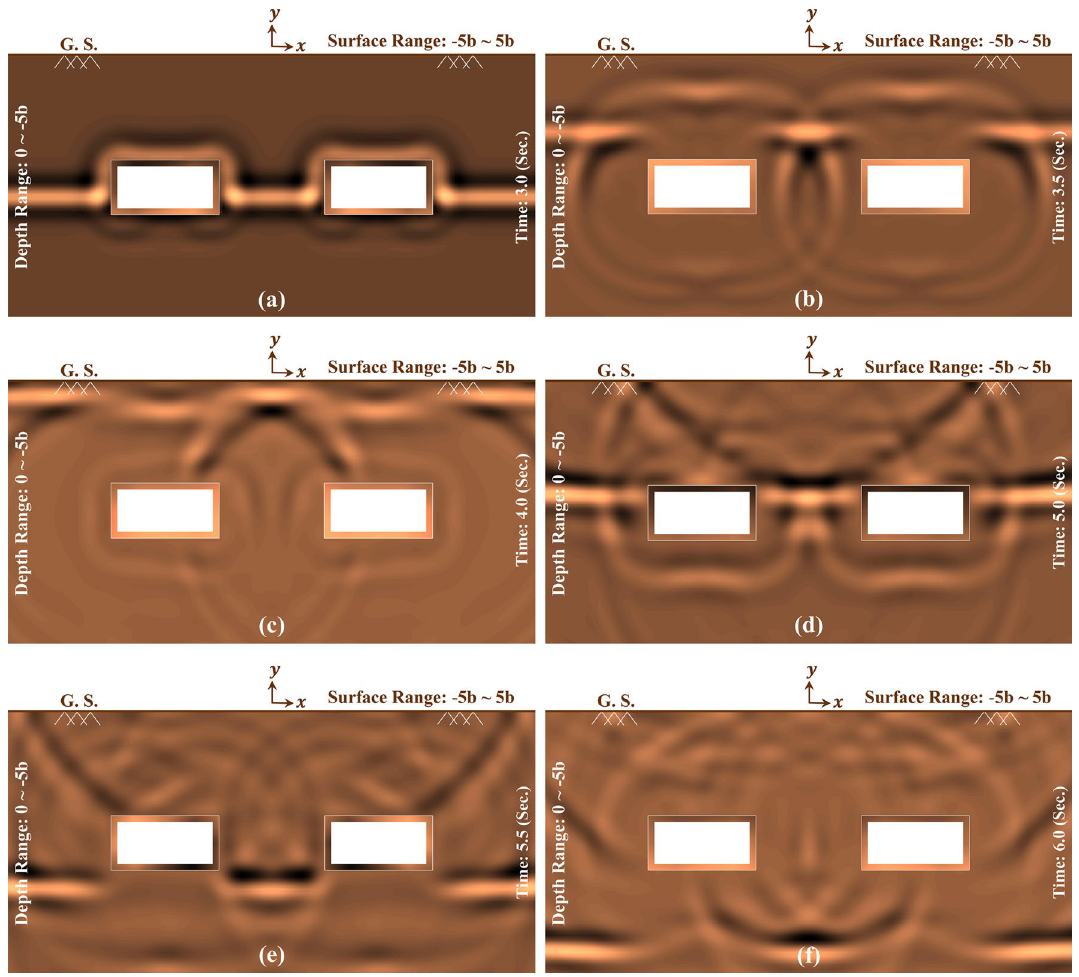
Fig. 9 Wave propagation snapshots and the procedure of the SH waves’ dispersion below the ground surface, for the model of twin rectan- gular-shaped lined tunnels subjected to vertical incident